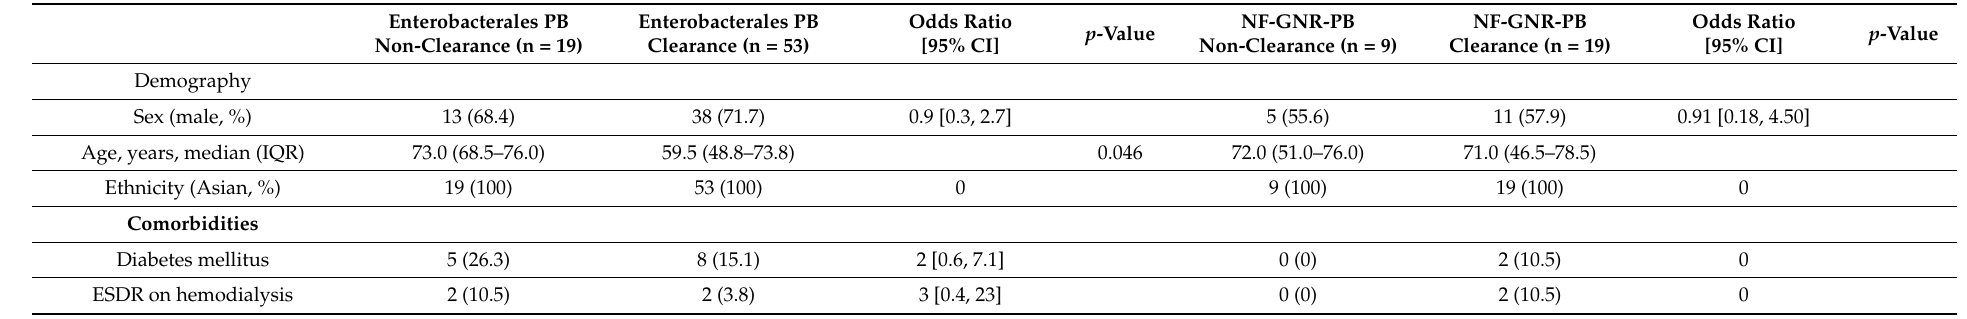
Table 2. Clinical characteristics of Enterobacterales and glucose non-fermentative gram-negative rod persistent bacteremia in terms of persistent bacteremia